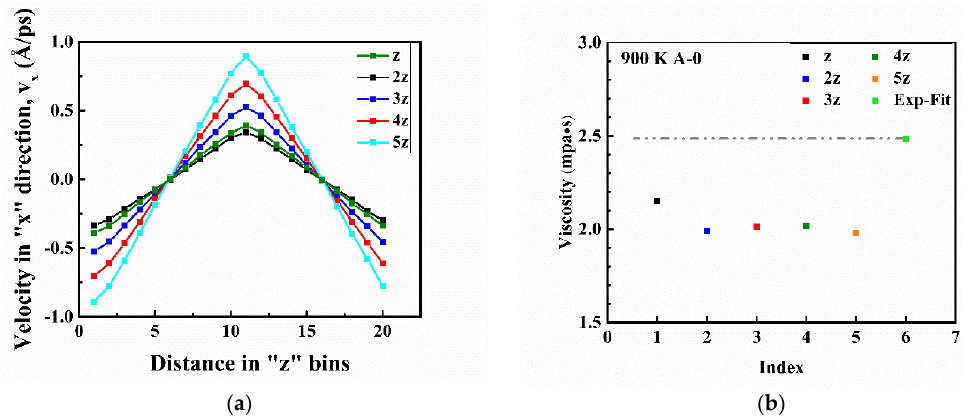
Figure 10. The influence of the z direction length on A-0 at 900 K. ( a ) Velocity profile of different z lengths. ( b ) The corresponding viscosities (Exp-fit is fitting by the Arrhenius equation based on the data obtained from [37], R 2 = 1.00).